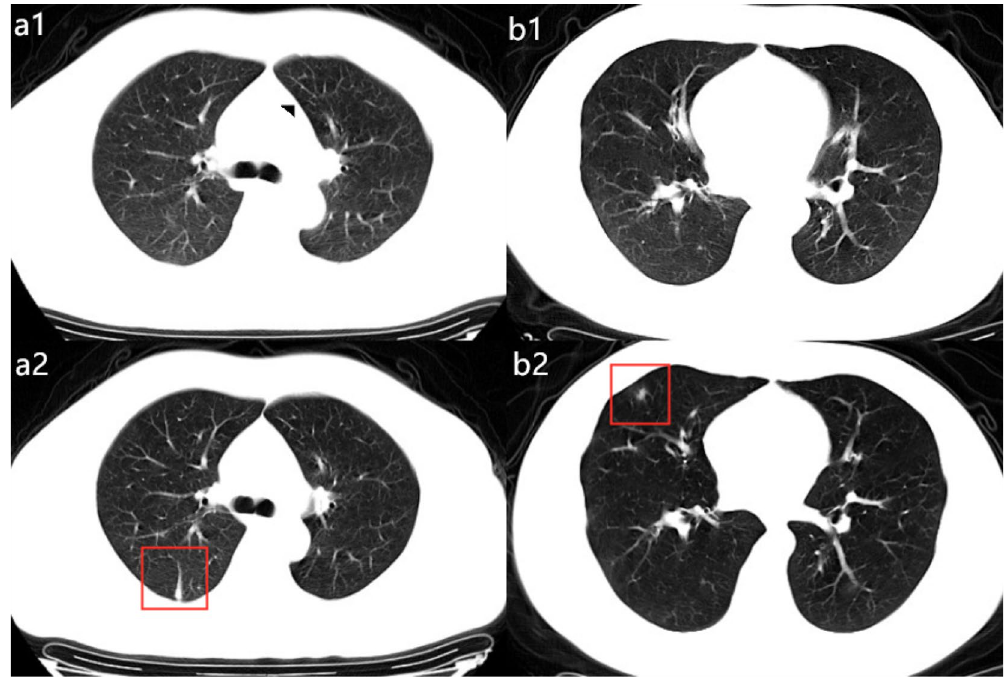
Figure 3. Examples of patients with admitting diagnosis as non-pneumonia in Group 2. ( a1 – a2 ) a 45-year-old man with confirmed with non-pneumonia COVID-19 and had hospitalization days of 16. Patients had fever at onset of disease, but normal CT images at the beginning of the admission ( a1 ), at 4th day on admission, the follow-up CT images demonstrated inflammatory appearance as linear shadowing ( a2 ). ( b1 – b2 ) a 31-year-old man diagnosed as non-pneumonia with COVID-19 who had cough at onset but normal CT images ( b1 ). Total hospitalization time was 18 days. After 4 days admission, an irregular consolidate nodule can be seen in the right middle lobe from the follow-up CT images ( b2